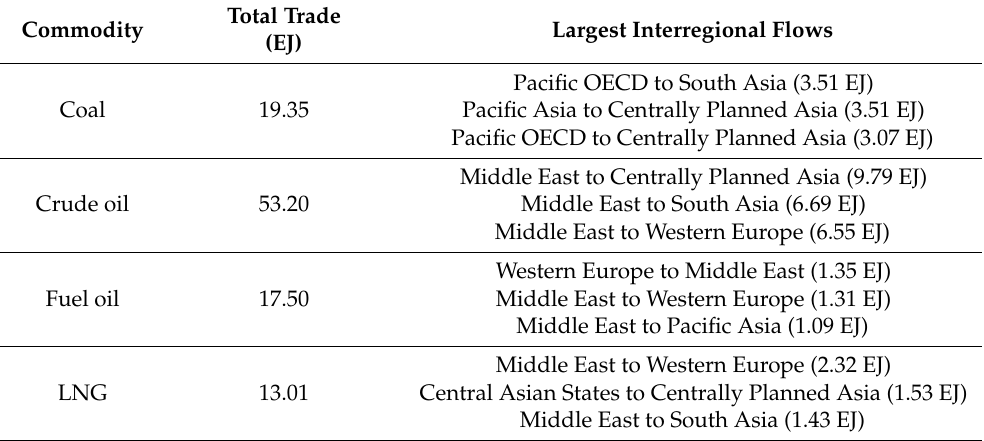
Table 1. Interregional trade in key fuels (2018). Energy flows are derived from the BACI bilateral trade database, which includes the value and tonnage of trade between countries at the HS6 level. We then convert trade flows from tonnage to EJ using specific energy values published by the IEA.